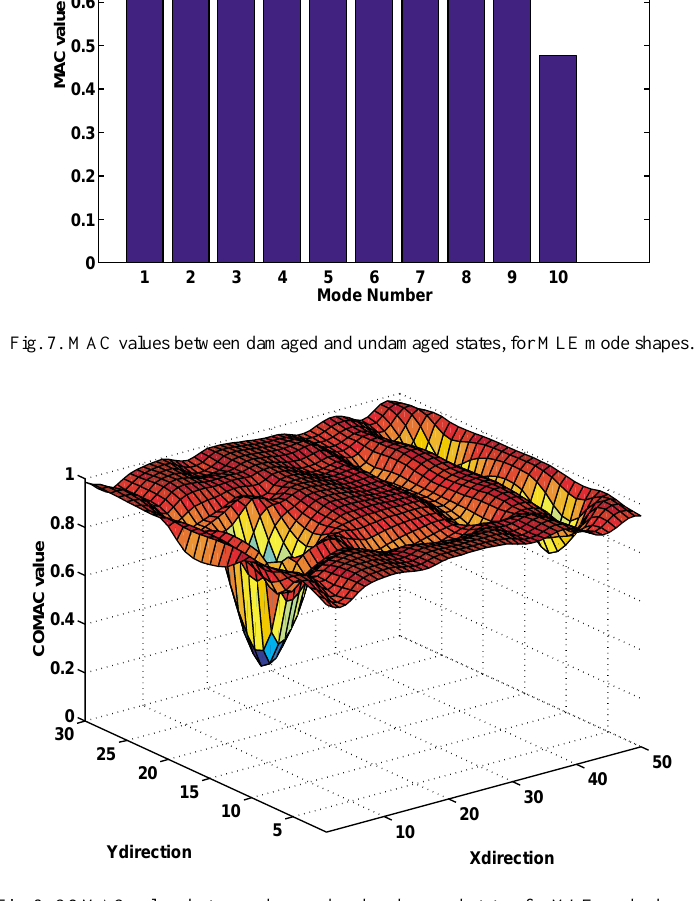
Fig. 8. COMAC values between damaged and undamaged states, for MLE mode